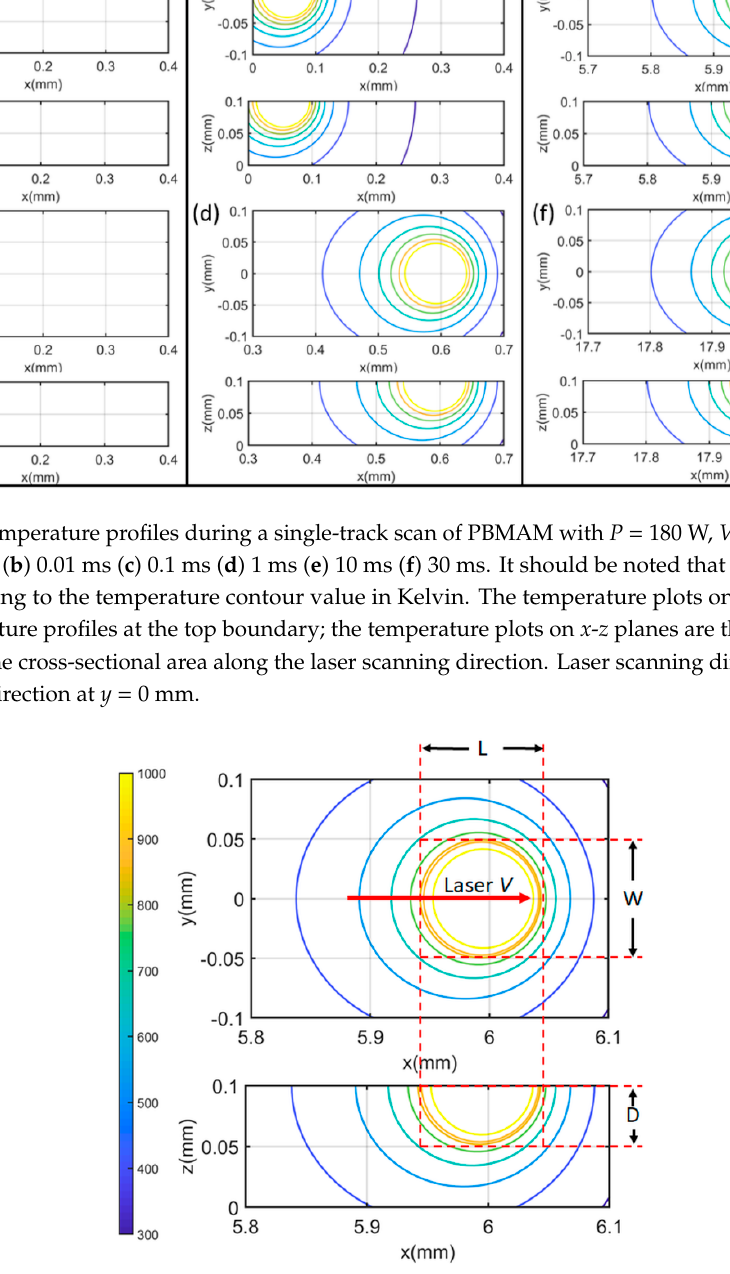
Figure 6. Molten pool length (L), molten pool width (W) and molten pool depth (D) calculated from the predicted temperature profile at the top boundary ( x - y plane) and the predicted temperature profile at the cross-sectional area ( x - z plane) at the laser scan direction along positive x -direction at y = 0 mm.